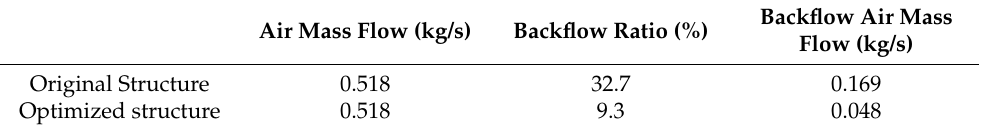
Table 2. Comparison of the backflow rate of the optimized cooling module and the original struc- ture.